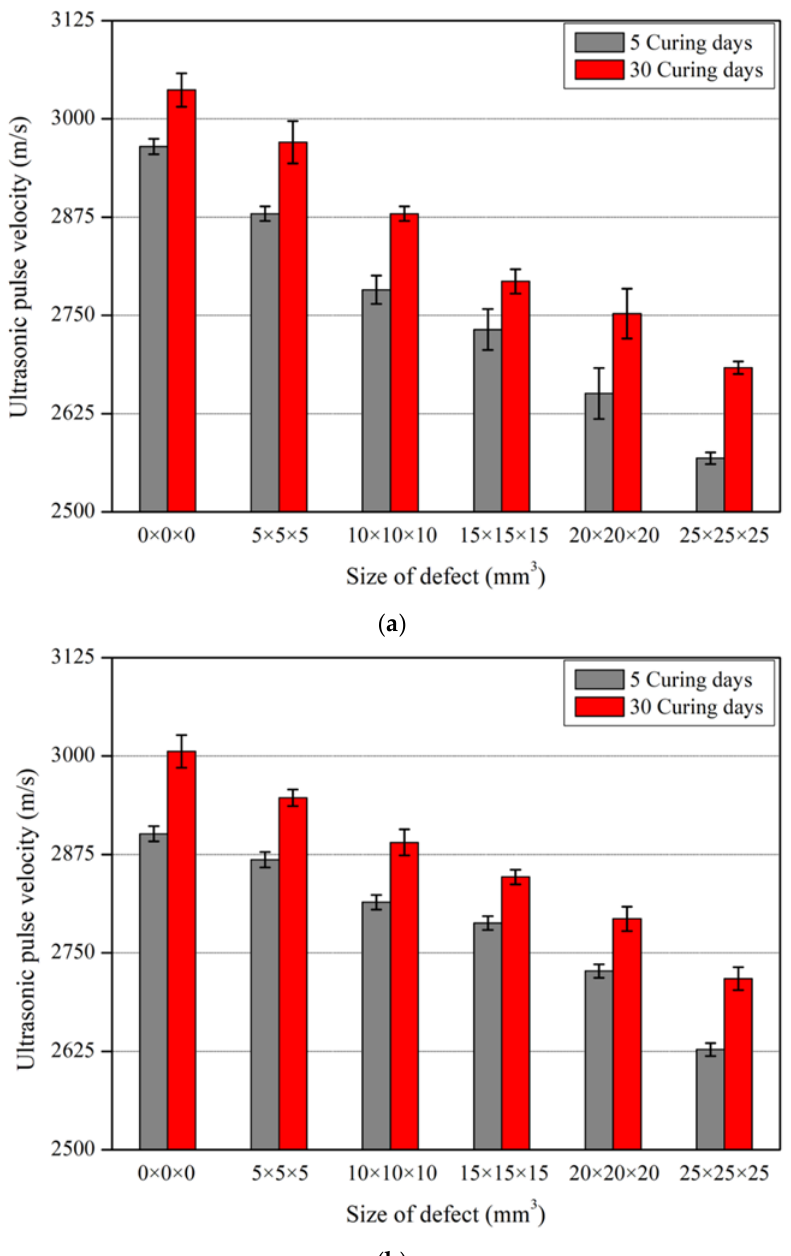
Figure 6. Ultrasonic pulse velocity according to defect size: ( a ) MWCNT 0.0 wt%; ( b ) MWCNT 1.0 wt%.